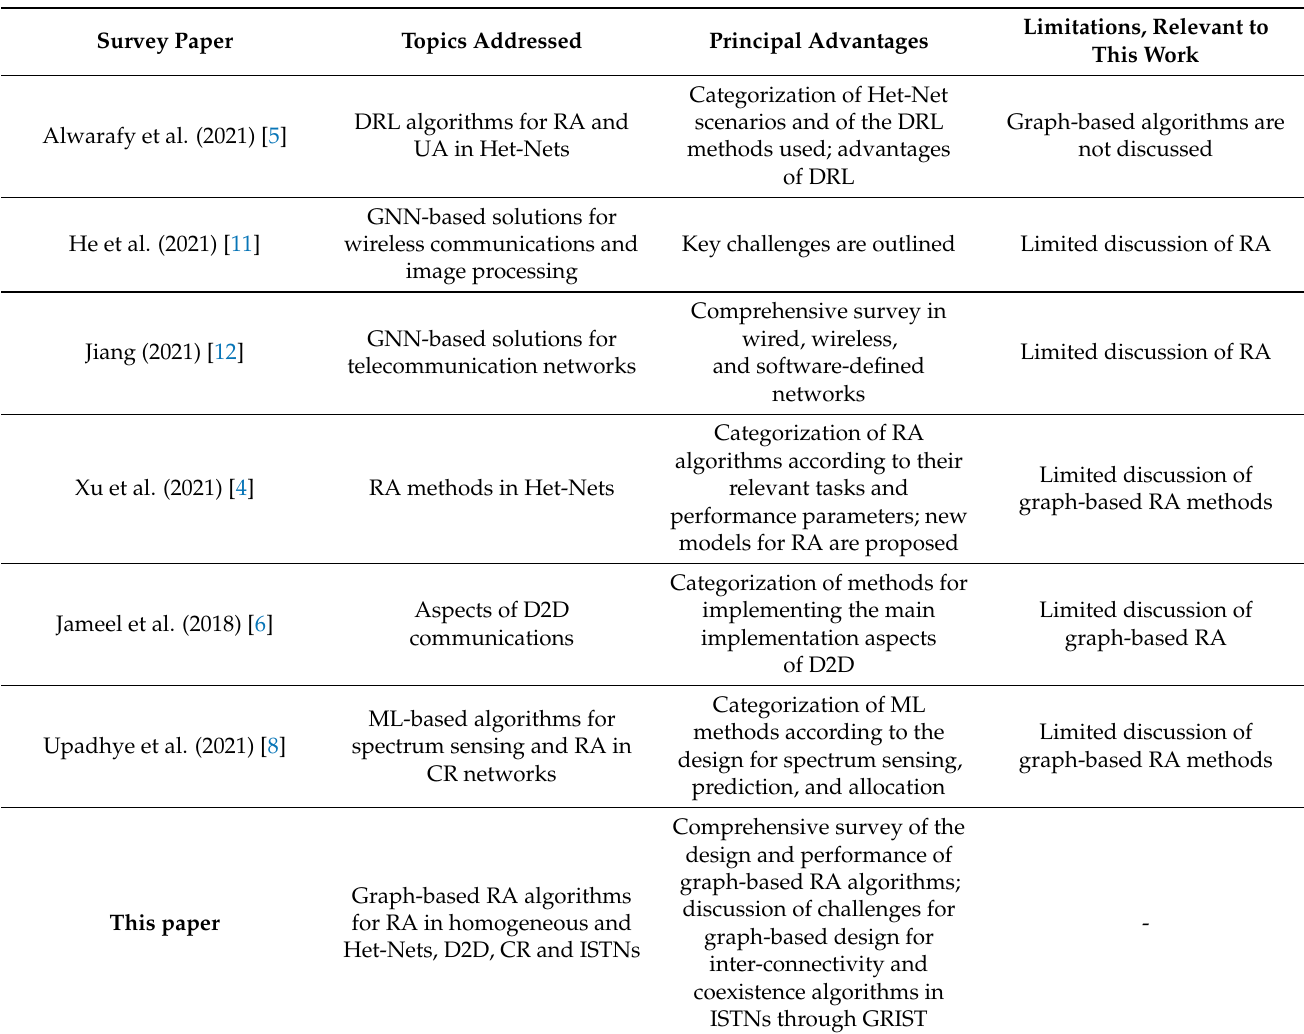
Table 5. Comparison of relevant surveys on graph methods applied in wireless communication